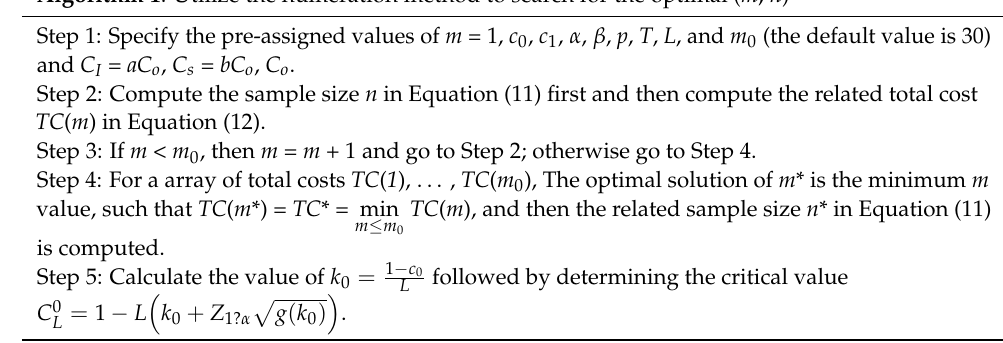
Algorithm 1 : Utilize the numeration method to search for the optimal ( m , n )